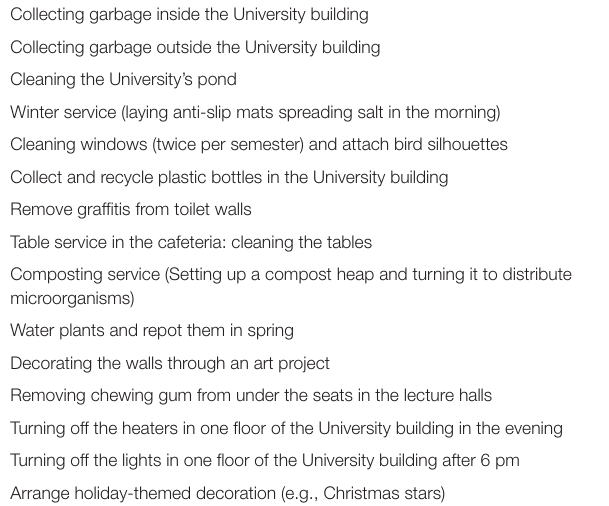
TABLE 1 | Items used in Study 1 to evaluate the planned University initiative.